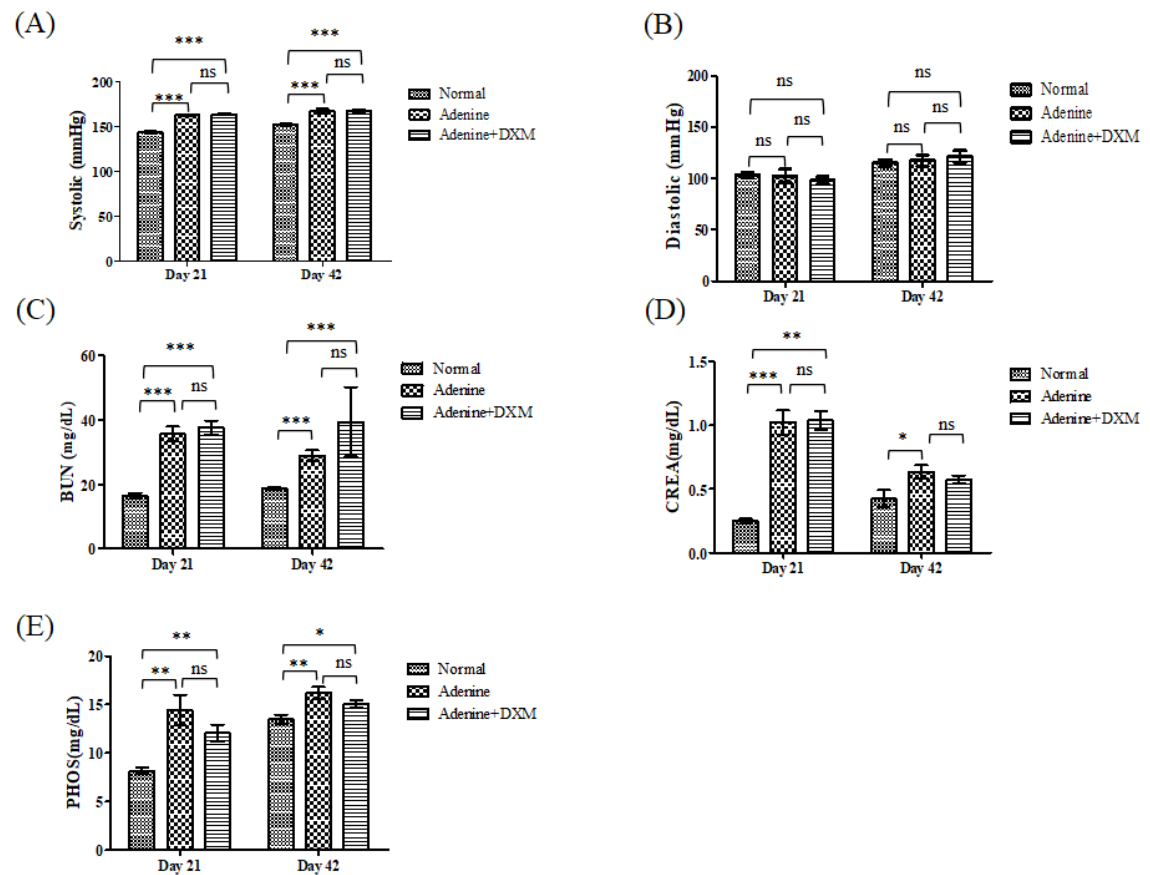
Figure 5. Effects of DXM on the blood pressure and biochemistry in a rat model of CKD (n = 8). ( A ) Systolic blood pressure; ( B ) diastolic blood pressure; ( C ) serum blood urea nitrogen (BUN); ( D ) creatinine (CREA); and ( E ) phosphorous (PHOS) levels during treatment. Not significant: ns, * p < 0.05, ** p < 0.01, *** p < 0.001.